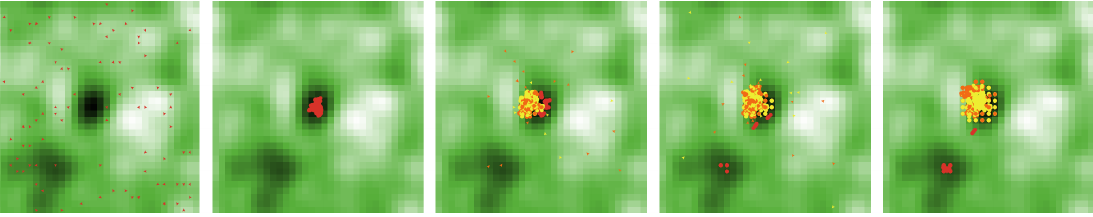
Figure 7. Evolution of Set D over time, from initialization (left) through end of simulation (right).